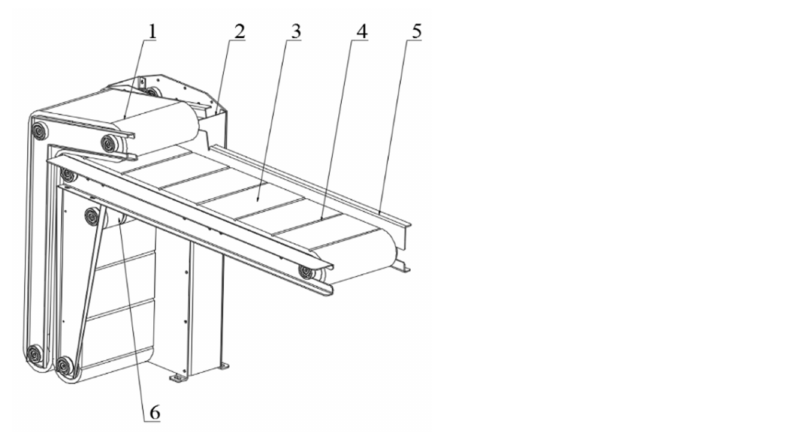
Figure 6. Belt Seedling Conveying Parts: 1. Upper seedling protection belt; 2. Transmission box; 3. Lower conveyor belt; 4. Seedling trough; 5. Link plate; 6. Drive roller.